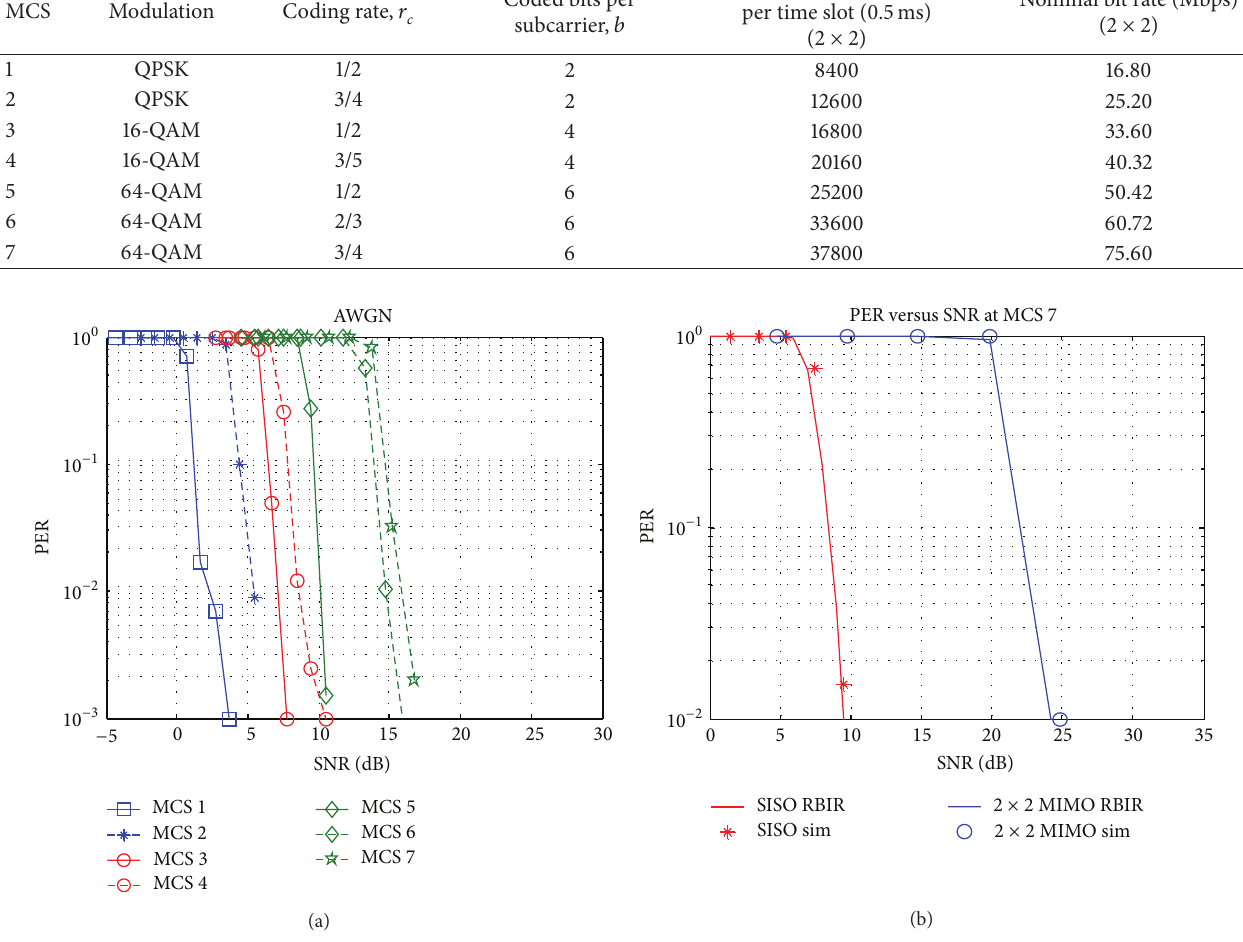
Figure 2: OFDMA for (a) PER under ideal AWGN channel conditions and (b) validation of RBIR abstraction for a wideband channel ( 2 × 2 SM with MCS mode